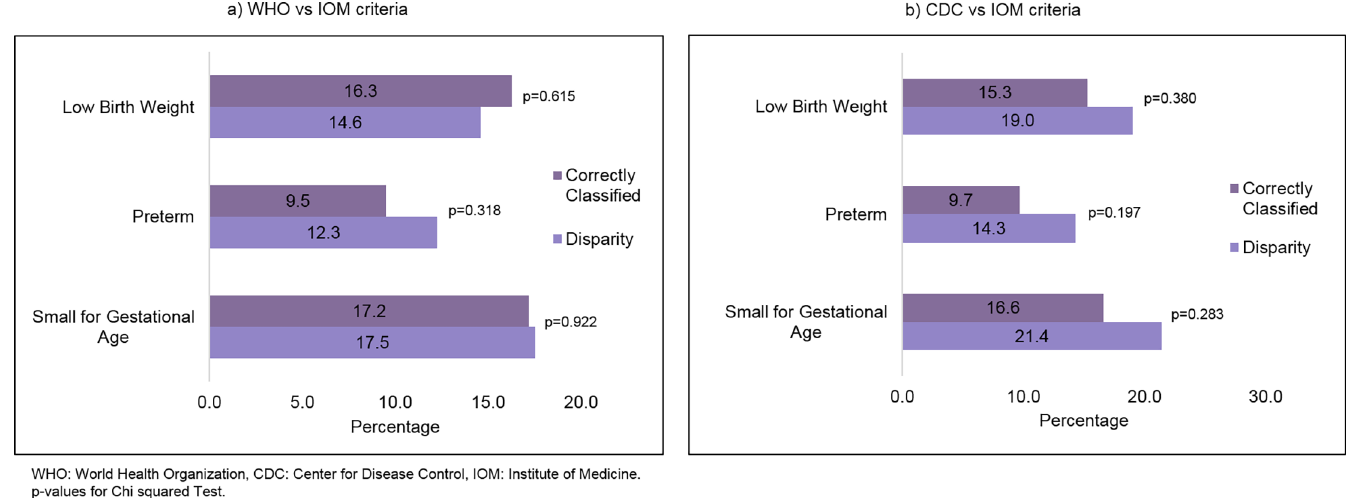
Fig 3. Distribution (%) of neonatal outcomes in adolescents with a pre-pregnancy BMI correctly classified compared to those with disparity classification, according to different criteria of pre-pregnancy BMI